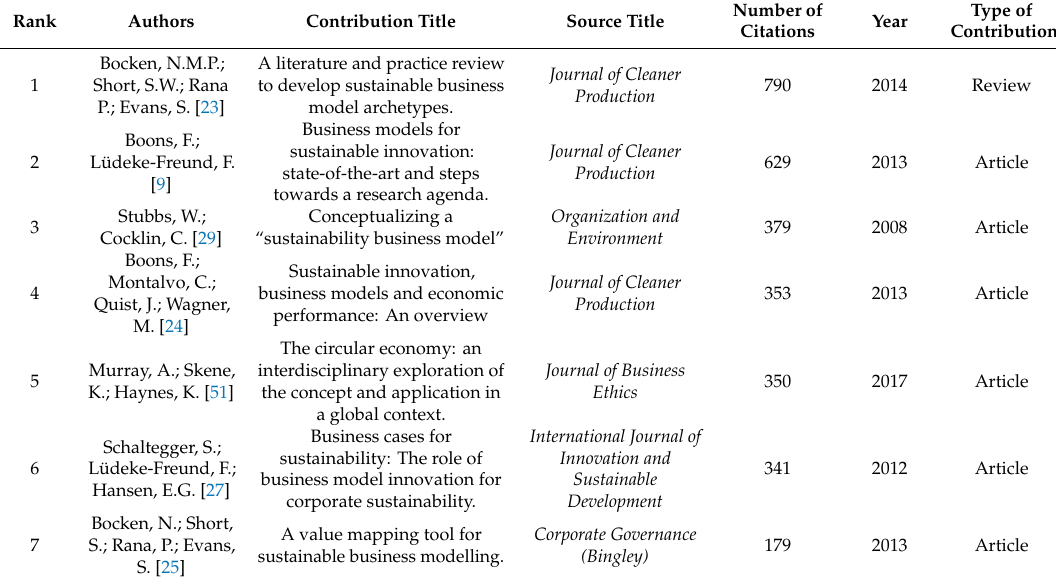
Table 7. Most cited papers in sustainable business models’